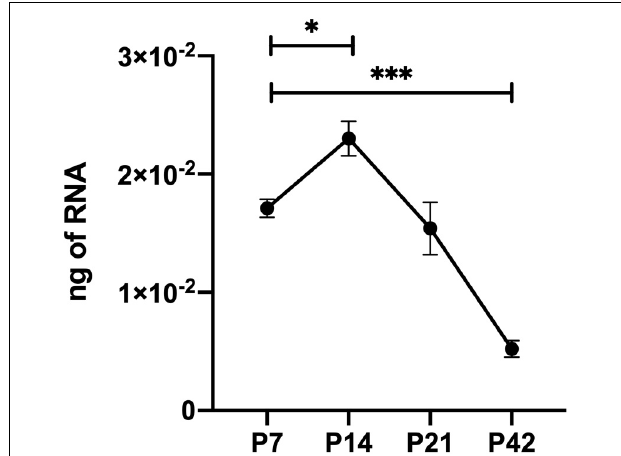
FIGURE 1 | Thrombospondin-1 (TSP1) expression during retinal vascularization. RNA was prepared from retinas of C57BL/6j mice at the noted times during retinal vascular development and maturation. qPCR was utilized to analyze TSP1 expression as noted in section “Materials and Methods”. Please note increased TSP1 expression at P14 with subsequent decline at P42. ∗ P < 0.05, ∗∗∗ P < 0.001.